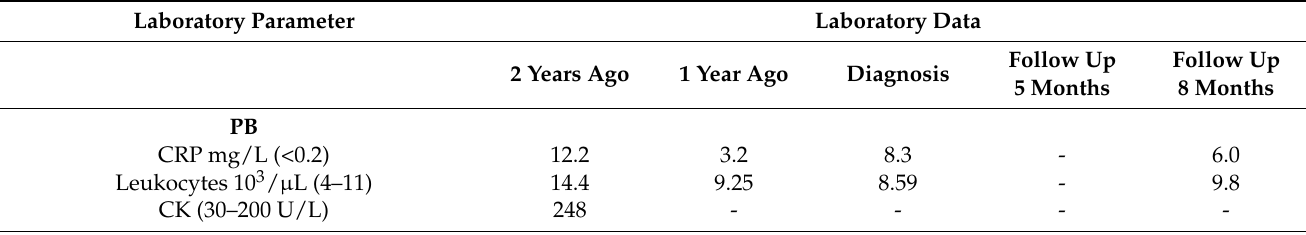
Table 1. Neuropsychological and laboratory